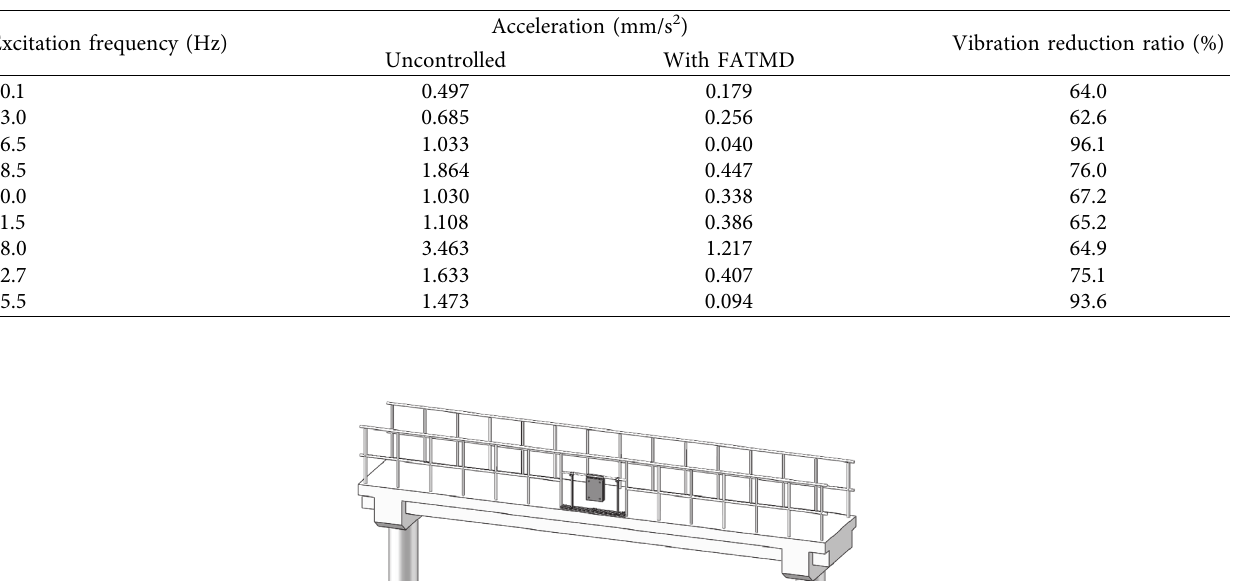
Table 2: Vibration reduction ratios of the FATMD.